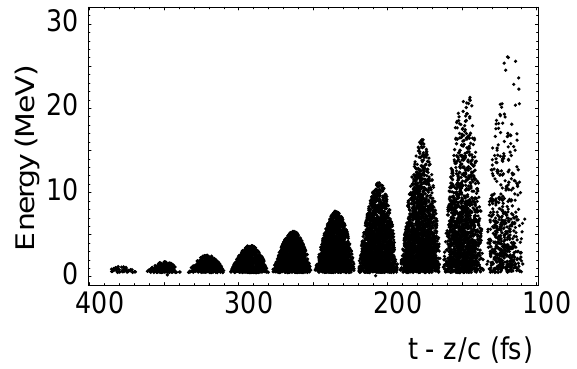
FIG. 3. Model for SMLW bunch: opening angle vs